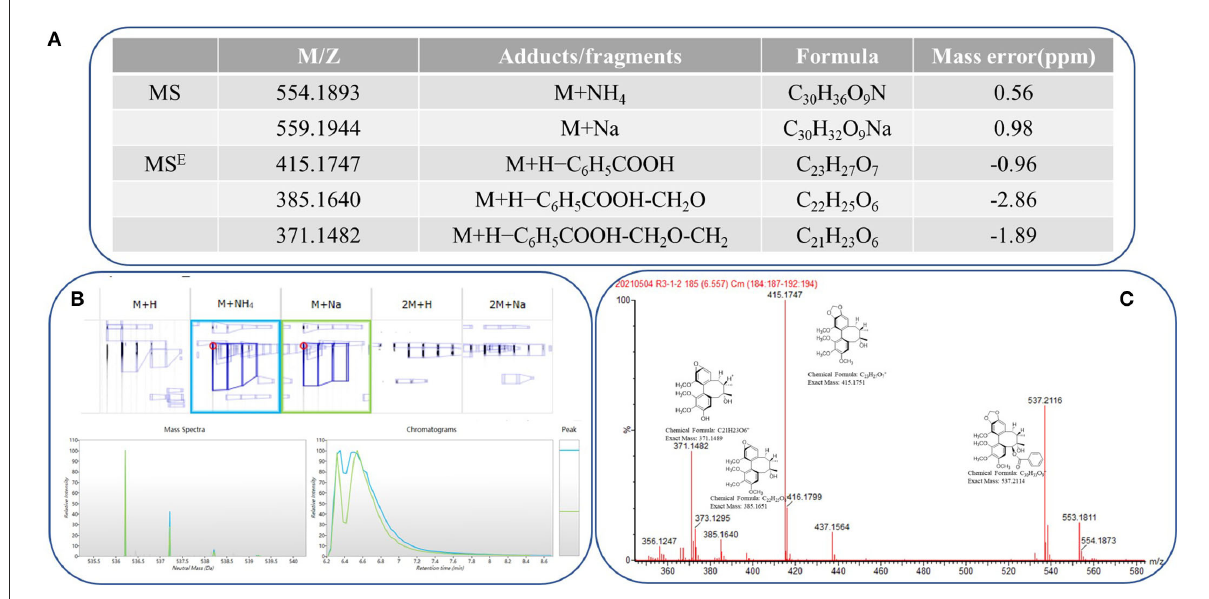
FIGURE1 Progenesis QI showing the identification of schisantherin A from the filtered metabolic features. (A) Low-energy major precursor exact mass schisantherin A adduct ions and corresponding high-energy fragment ions. (B) Common adduct ions for schisantherin A. (C) Structure and exact mass number of fragment ions.